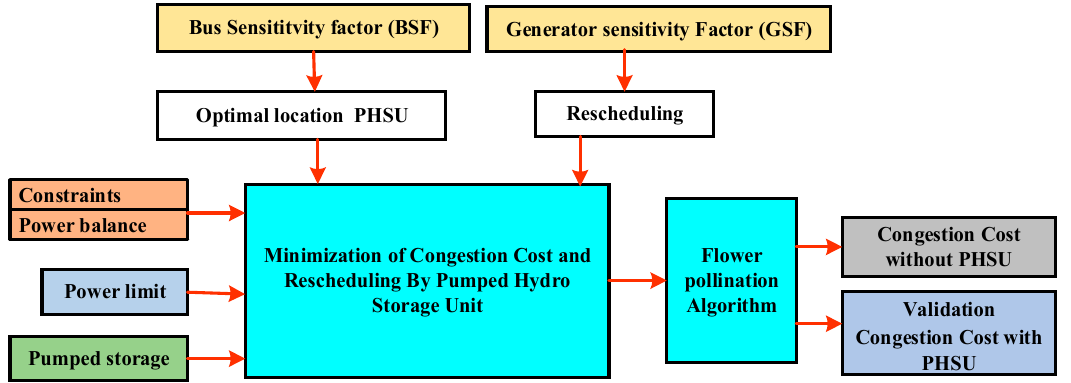
Figure 1. Congestion cost minimization using Flower Pollination Algorithm (FPA) and its validation with other optimization techniques (Part I).